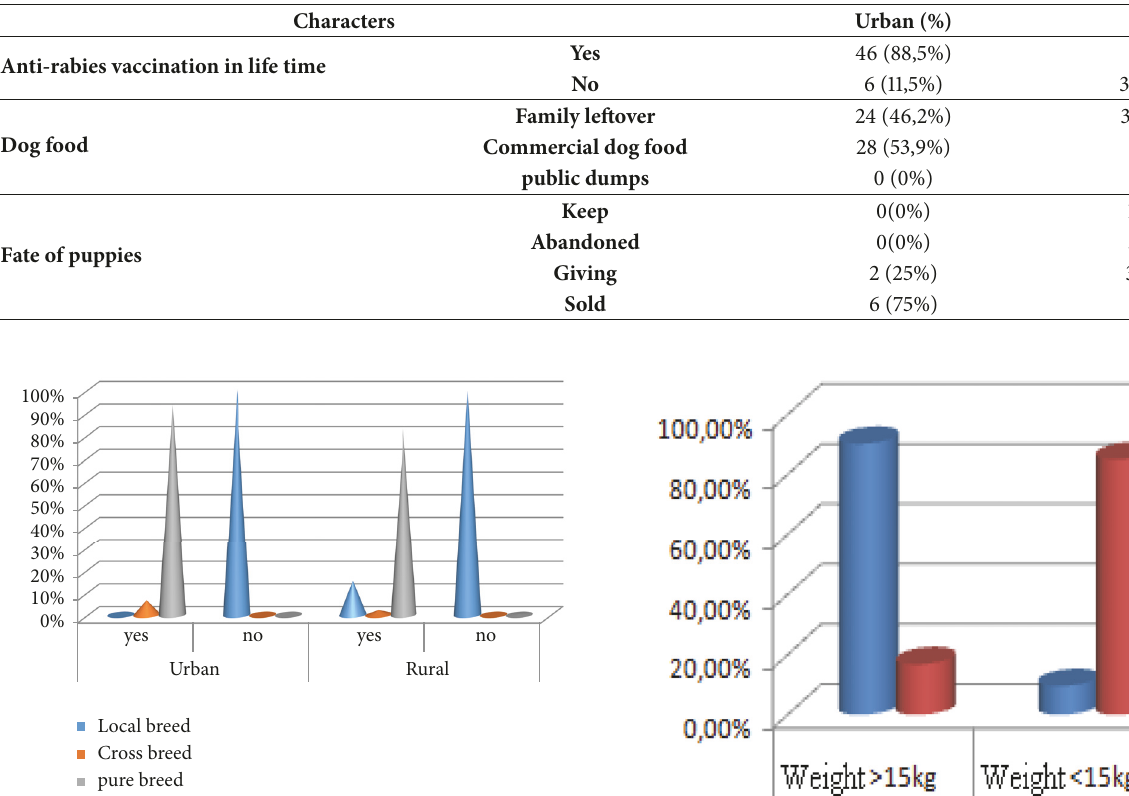
Table 4: Owner’s attitude towards the feeding and vaccination.